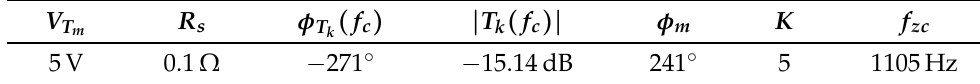
Table 7. Parameters of the PI controller with GCF = 2 kHz.